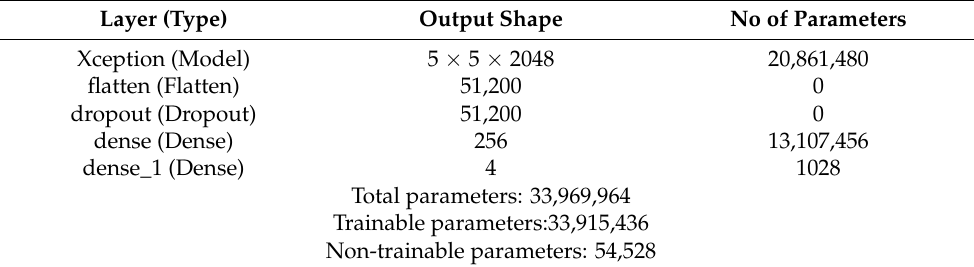
Table 5. CoroNet Architecture Details.